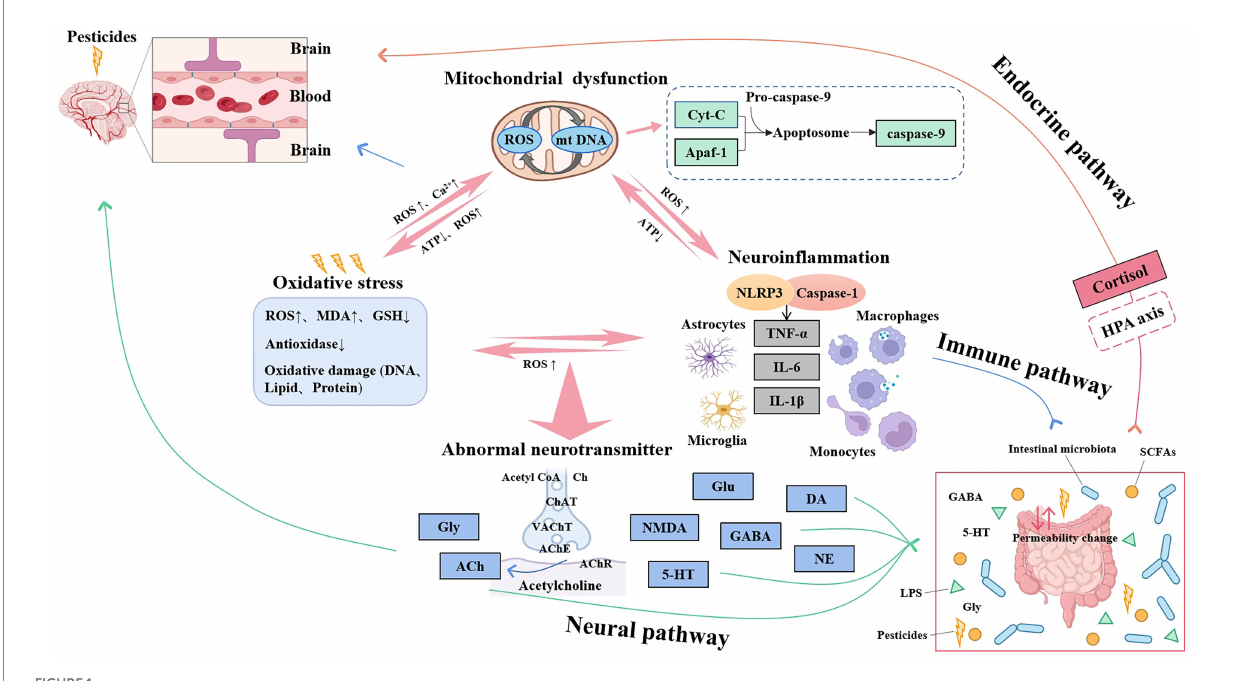
FIGURE 1 Relationship between mechanisms of pesticides-induced cognitive